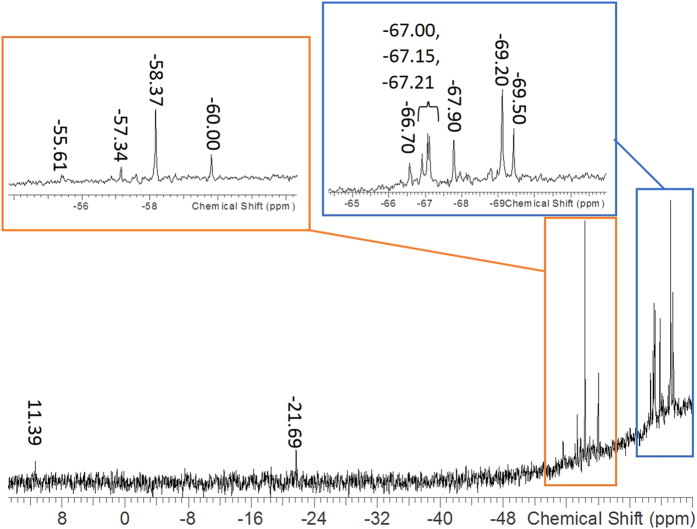
29Si NMR of compound 1, showing peaks at −69.50, −69.20, −67.90, −67.21, −67.15, −67.00, −66.70, −60.00, −58.37, −57.34, −55.61, −21.67, 11.39 ppm, insets show close-up of the peaks representing its structure.